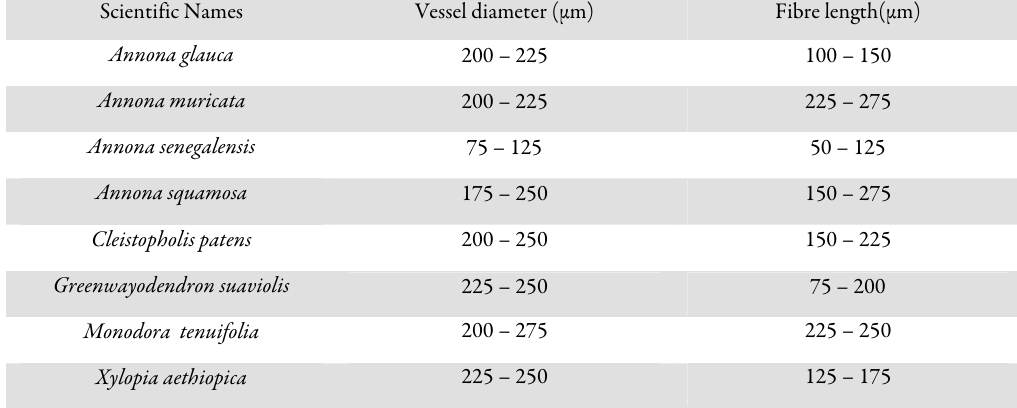
Tab. 1. Dimension of the tissues of the woods